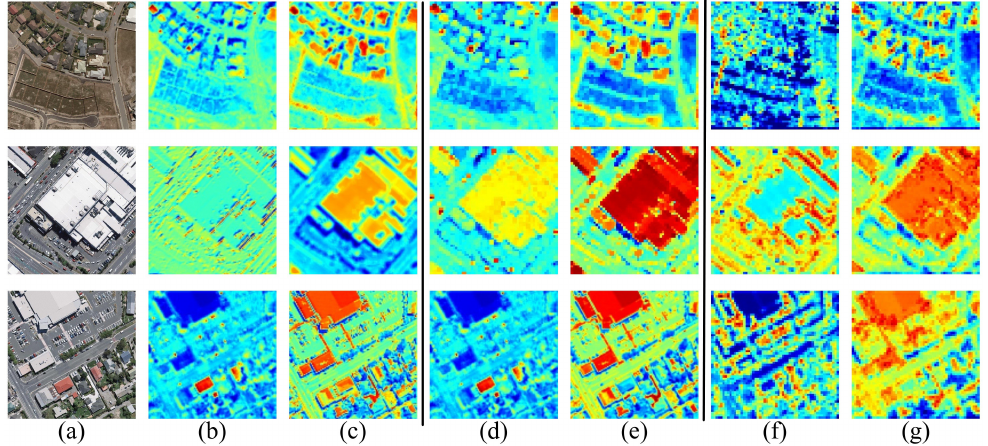
Figure 13. Visualization of features in different convolution layers: ( a ) the original remote sensing imagery, ( b ) feature maps in conv1 without attention module, ( c ) feature maps in conv1 with attention module, ( d ) feature maps in conv2 without attention module, ( e ) feature maps in conv2 with attention